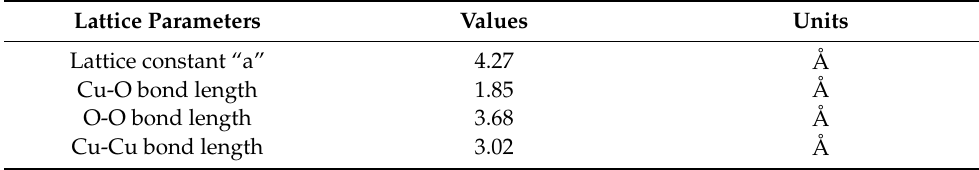
Table 1. Tabulated lattice parameters for Cu 2 O obtained by XRD. Data from [28], with the permission from the American Physical Society.